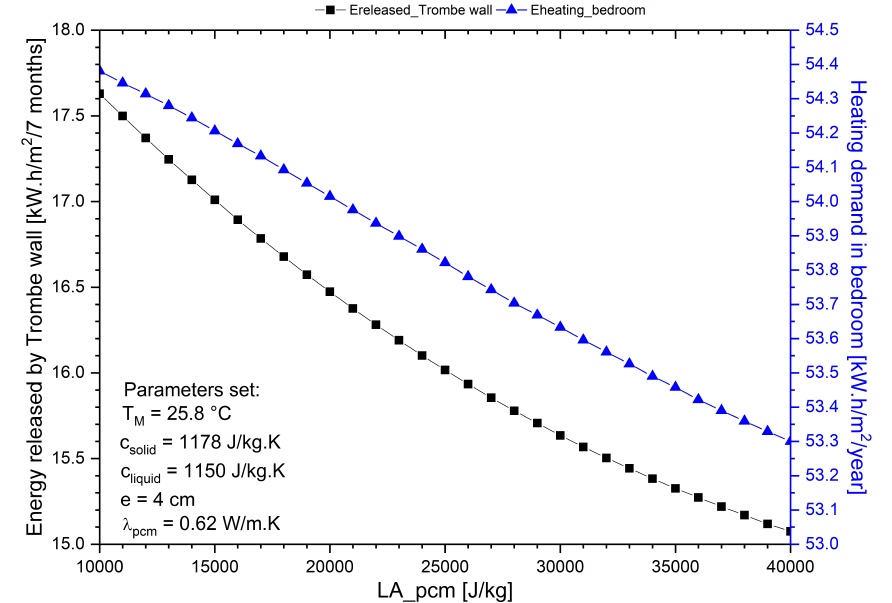
Figure 3. Energy supplied by the solar Trombe wall and annual heating demand vs. latent heat during the cold season (7 months total: January–April and October–December).